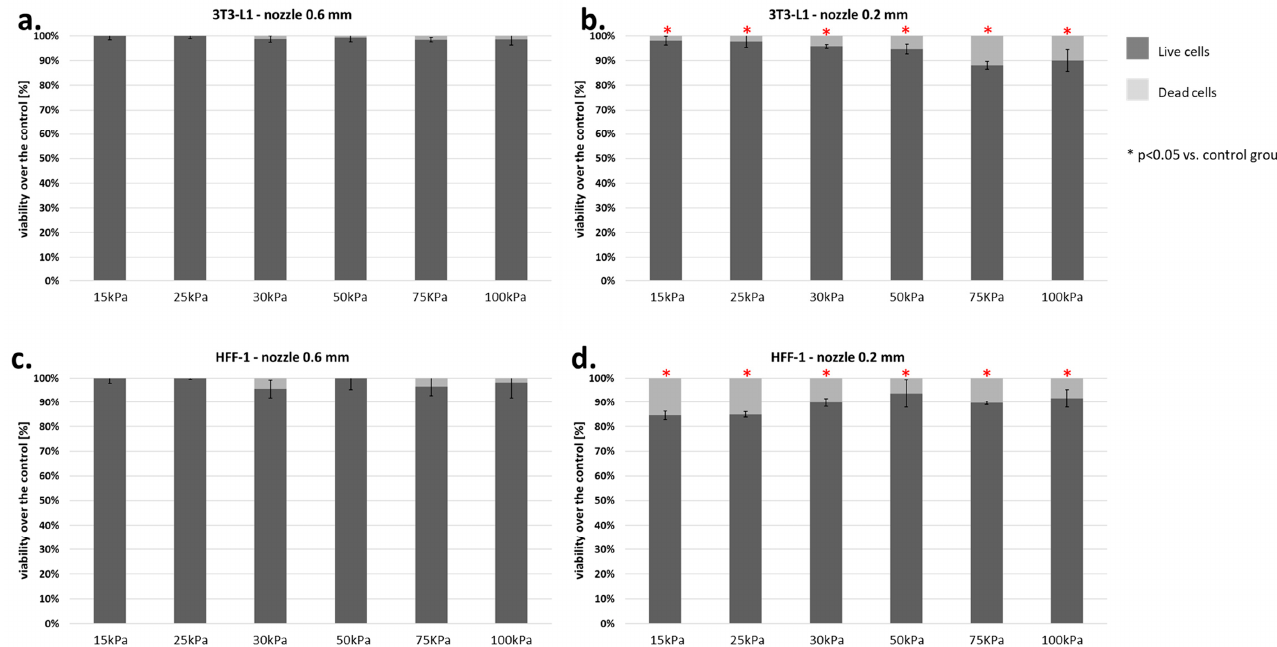
Figure 11. ( a–d ) Viability of fibroblasts (3T3-L1 and HFF-1) subjected to the bioprinting process with different pressures and nozzles with an internal diameter of 0.6 (Figure 7a,c) and 0.2 mm (Figure 7b,d). As a carrier material, 3% ( w/v ) alginate was used, and the vitality of the islets was assessed based on FDA/PI staining and determined in accordance with Equation (7). Our control consisted of cells right after the trypsinization process. The P -value for each pressure was calculated in comparison to the control group using Fisher’s method, and statistical significance ( P < 0.05) was observed in each pressure for 0.2 mm nozzle. N = 3.